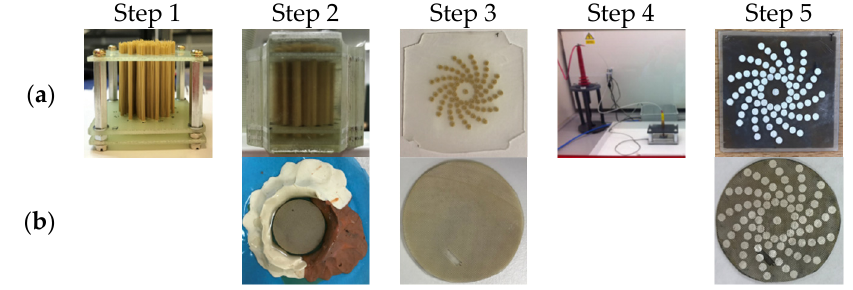
Figure 5. Illustration of the manufacturing process for ( a ) the CECAT active layer and ( b ) the C1–3 active layer.